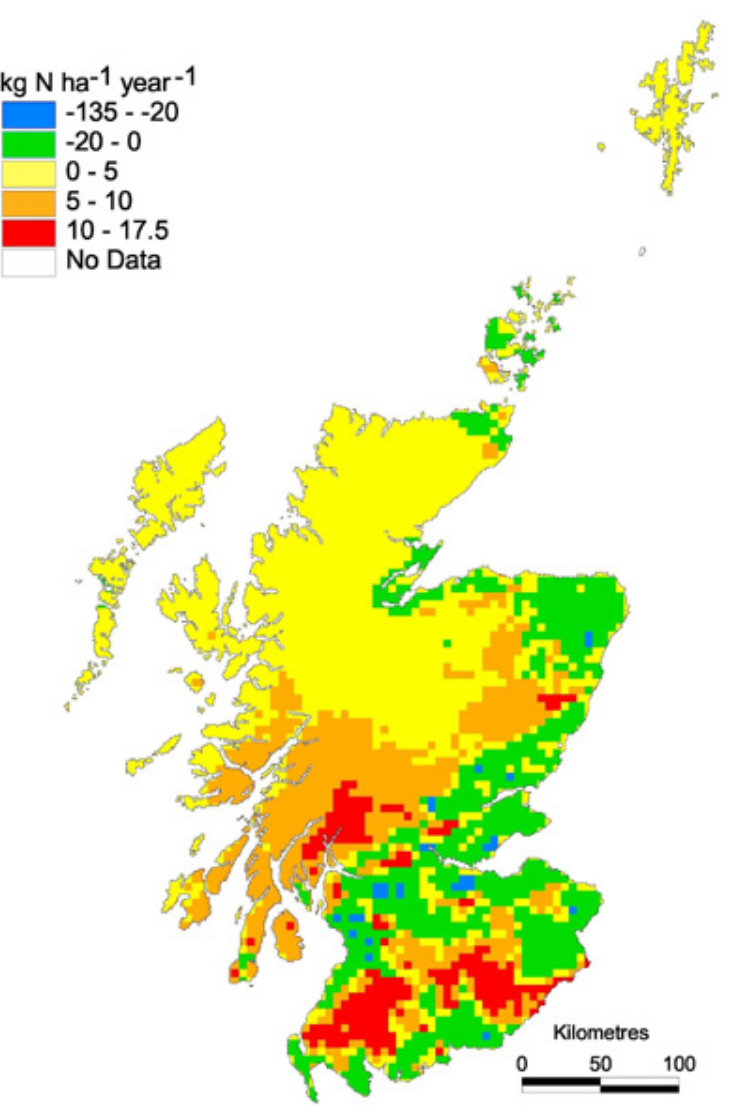
FIGURE 9. Modelled difference between NH 3 emission and grid-averaged NH x deposition in Scotland for 1996. In areas with positive values there is a net import of NH x (deposition larger than emission), while in areas with negative numbers there is a net export of NH x (emission larger than